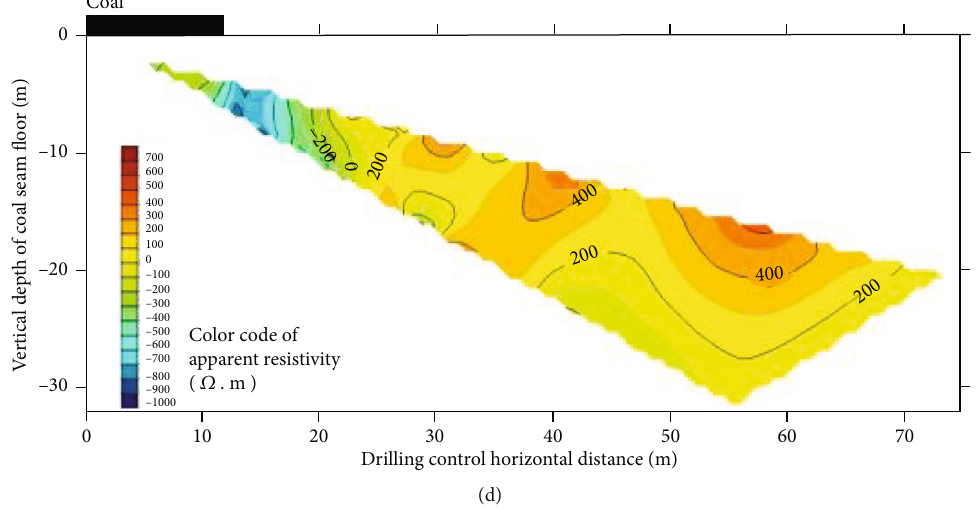
Figure 13: Working face is 86.7m away from the ori fi ce (a). Working face is 48.0m away from the ori fi ce (b). Working face is 23.0m away from the ori fi ce (c). Working face is 12.6m away from the ori fi ce